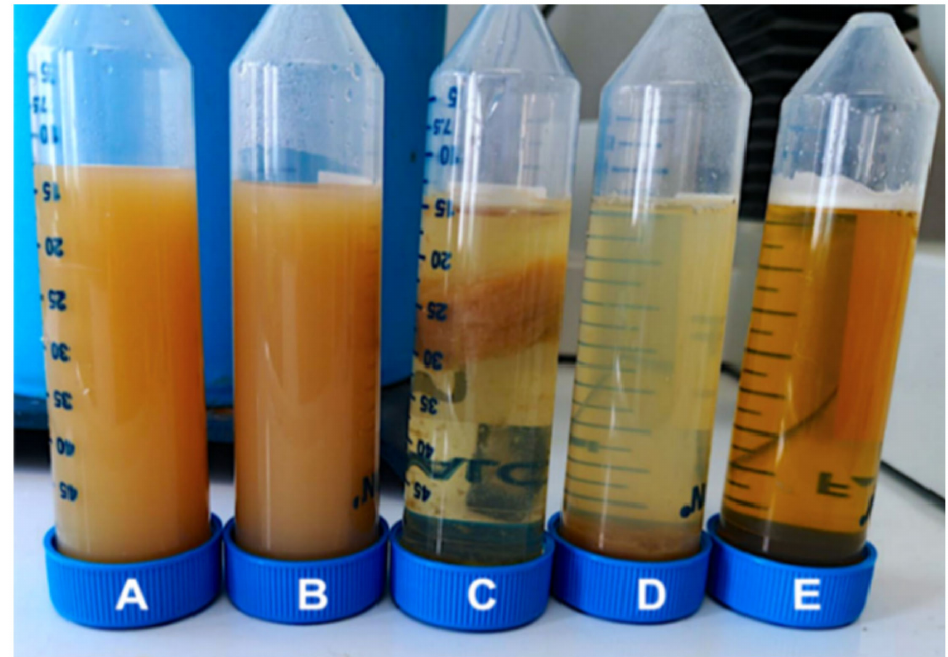
Figure 1. LNPs obtained during the nanoprecipitation process. ( A ) Stable colloidal LNPs (30 days at 25 ◦ C). ( B ) Low stable colloidal LNPs (1–2 days at 25 ◦ C). ( C ) Aggregates of LNPs. ( D ) Formation of a precipitate. ( E ) Absence of